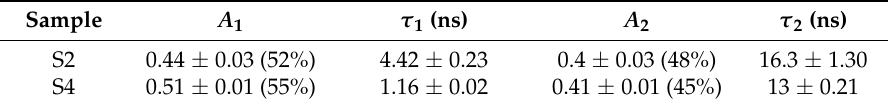
Table 1. Bi-exponential fitting result of S2 and